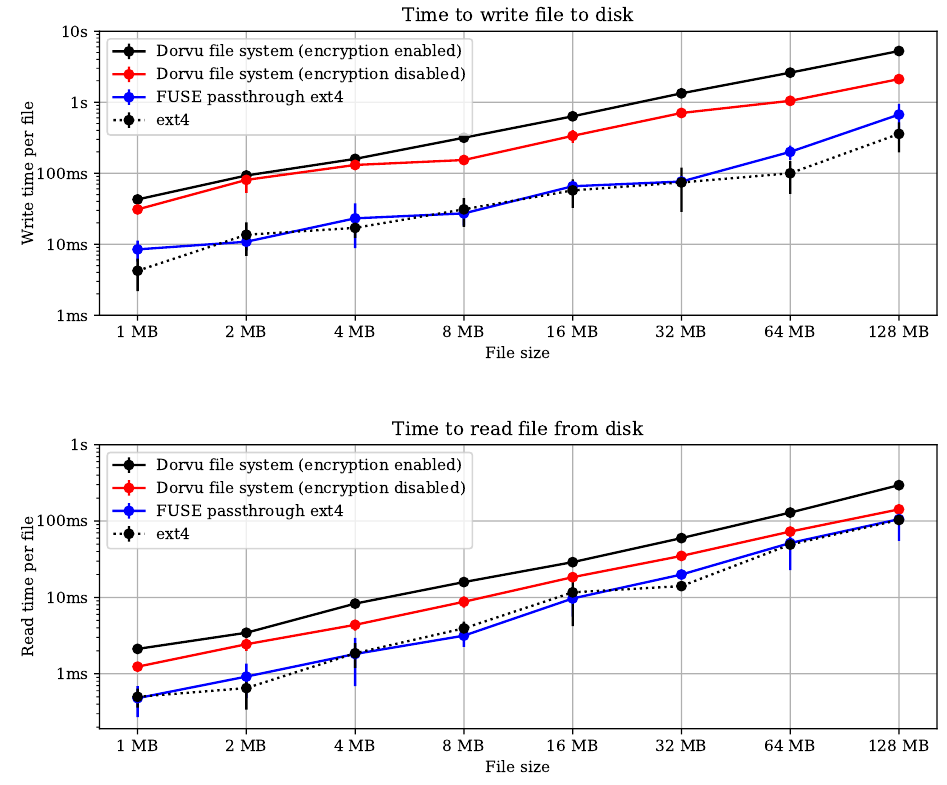
Figure 5. Time measured for read and write operations on varying file sizes and file system con- figurations. The top graph indicates measurements of the write operation, while the bottom graph indicates the read operation. The y -axis represents time spent on an operation, measured in seconds, plotted on a logarithmic scale. The various files used for this experiment are listed on the x -axis, represented by their file sizes. Plots include error bars, indicating standard deviation on the y